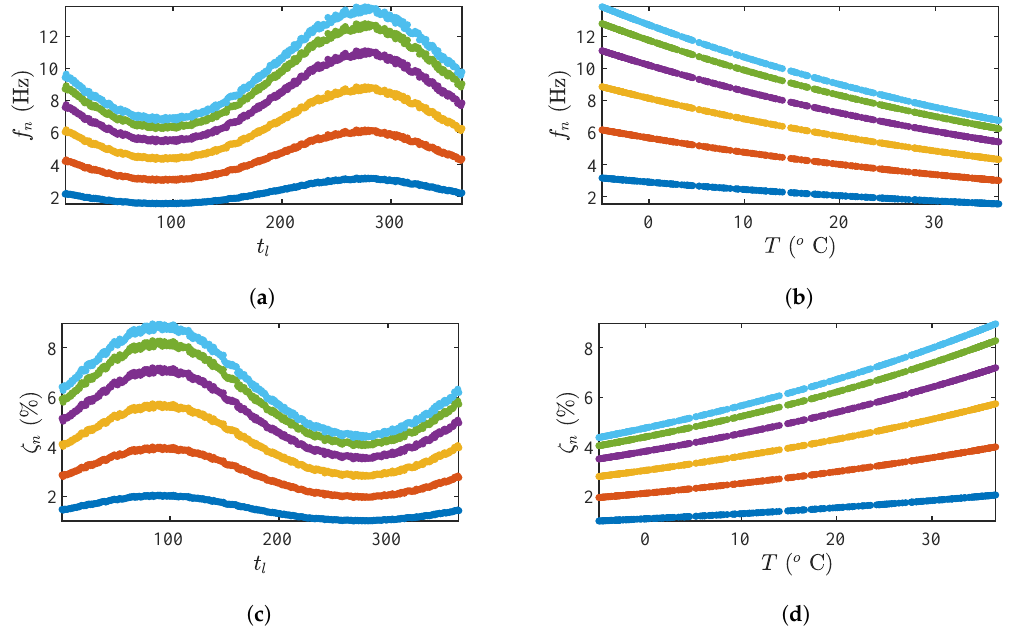
Figure 5. Spring-mass-damper: structural vibration modes for the temperature realization of Figure 3: